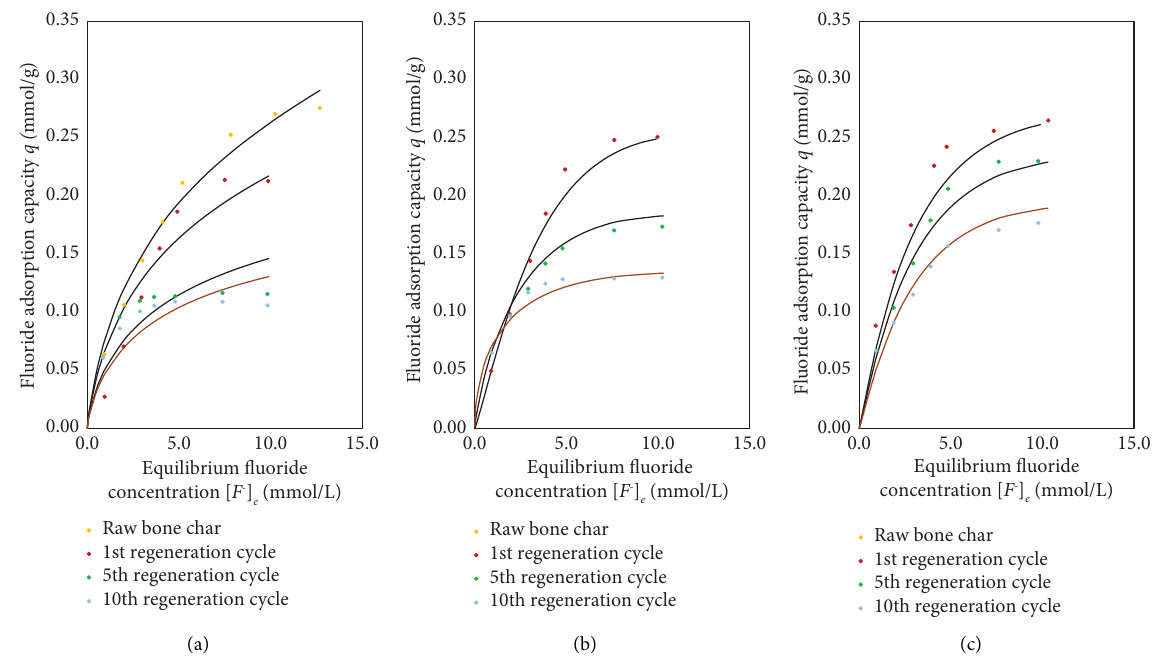
Figure 3: Fluoride adsorption isotherms using raw and regenerated bone char samples at pH 7 and 30 ° C. (a) Regeneration with 0.01 M NaOH. (b) Regeneration with 0.05 M NaOH. (c) Regeneration with 0.075M NaOH.